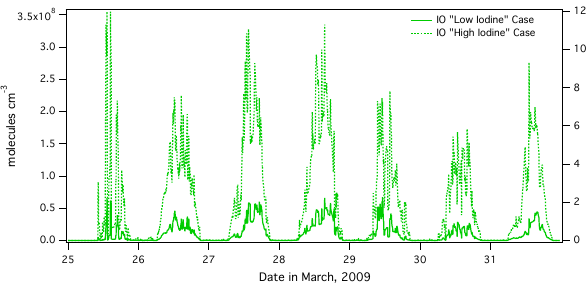
Figure 4. Simulated time series of IO shown for the “Low Iodine” (solid line) and “High Iodine” (dashed line) scenarios. The “Low Iodine” scenario and the “High Iodine” scenario correspond to a daytime average of 0.025 and 0.5pptv I 2 , respectively. Time is ex- pressed in Alaska Standard